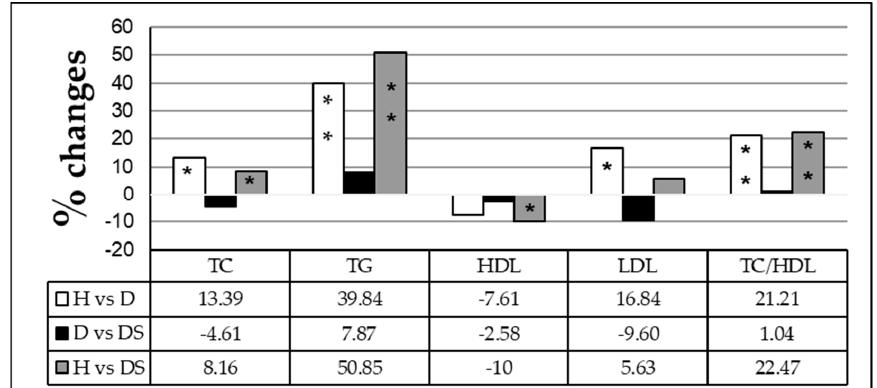
Figure 3. Percentage of change in lipid profile parameters among healthy individuals (H), diabetic patients (D), and diabetic patients sweetener consumers (DS). The comparison was performed using one-way ANOVA. Values presenting p > 0.05 were considered non-significant (NS). Significant values are represented by * p < 0.05 and ** p <0.001.